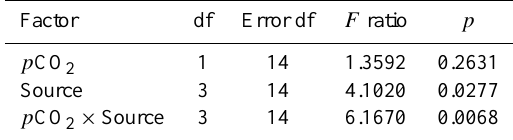
Table 7. Two-way ANOVA: metamorph